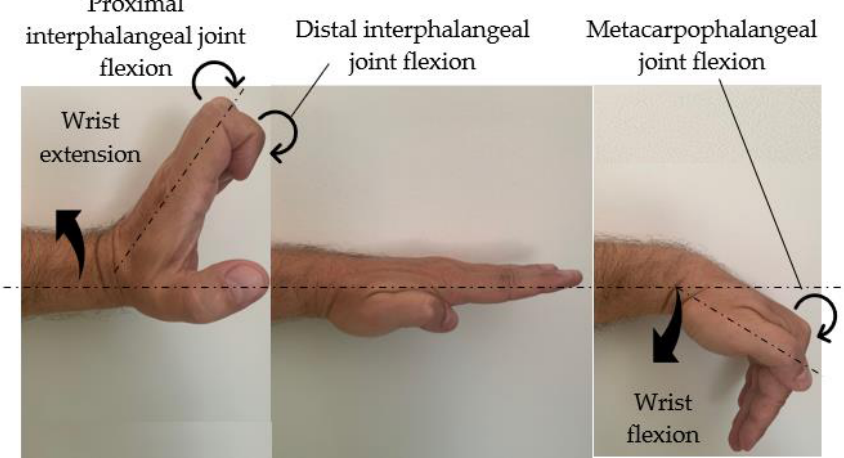
Table 1. Mobility characteristics of the wrist and finger joints. Figure 1. Flexion/extension of the wrist and flexion of the joints of the fingers.